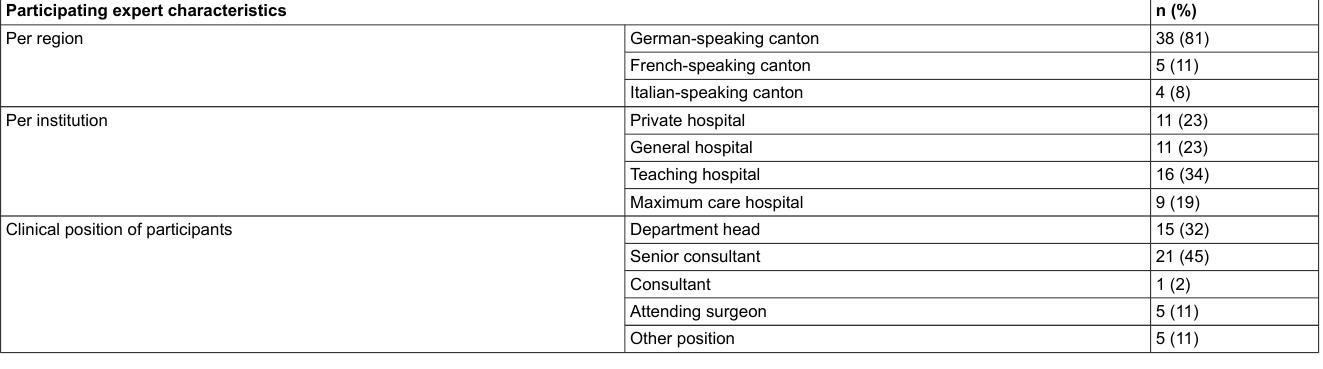
Table 2: Preoperative work-up Upper gastrointestinal tract